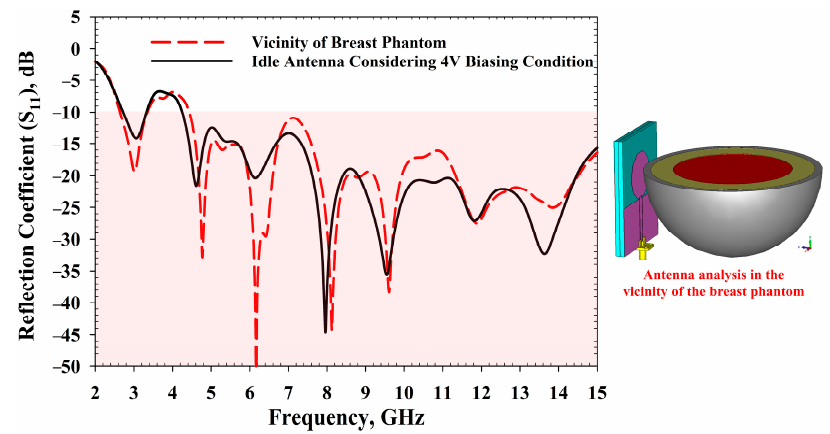
Figure 14. Effect of human tissue over antenna performance.